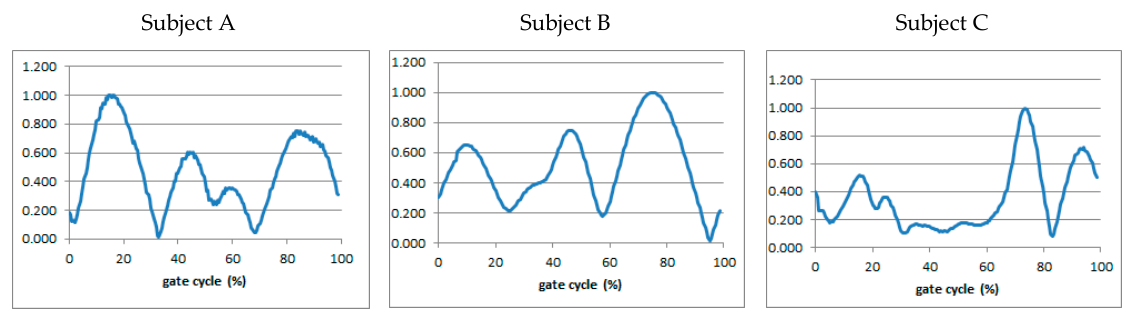
Figure 4. Ankle EP velocities of three runners with different shoe